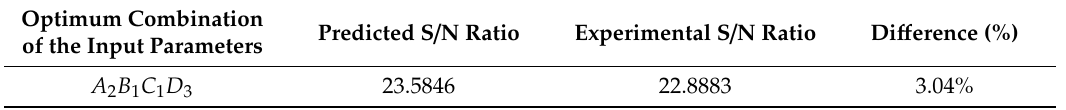
Table 14. Results of the confirmatory